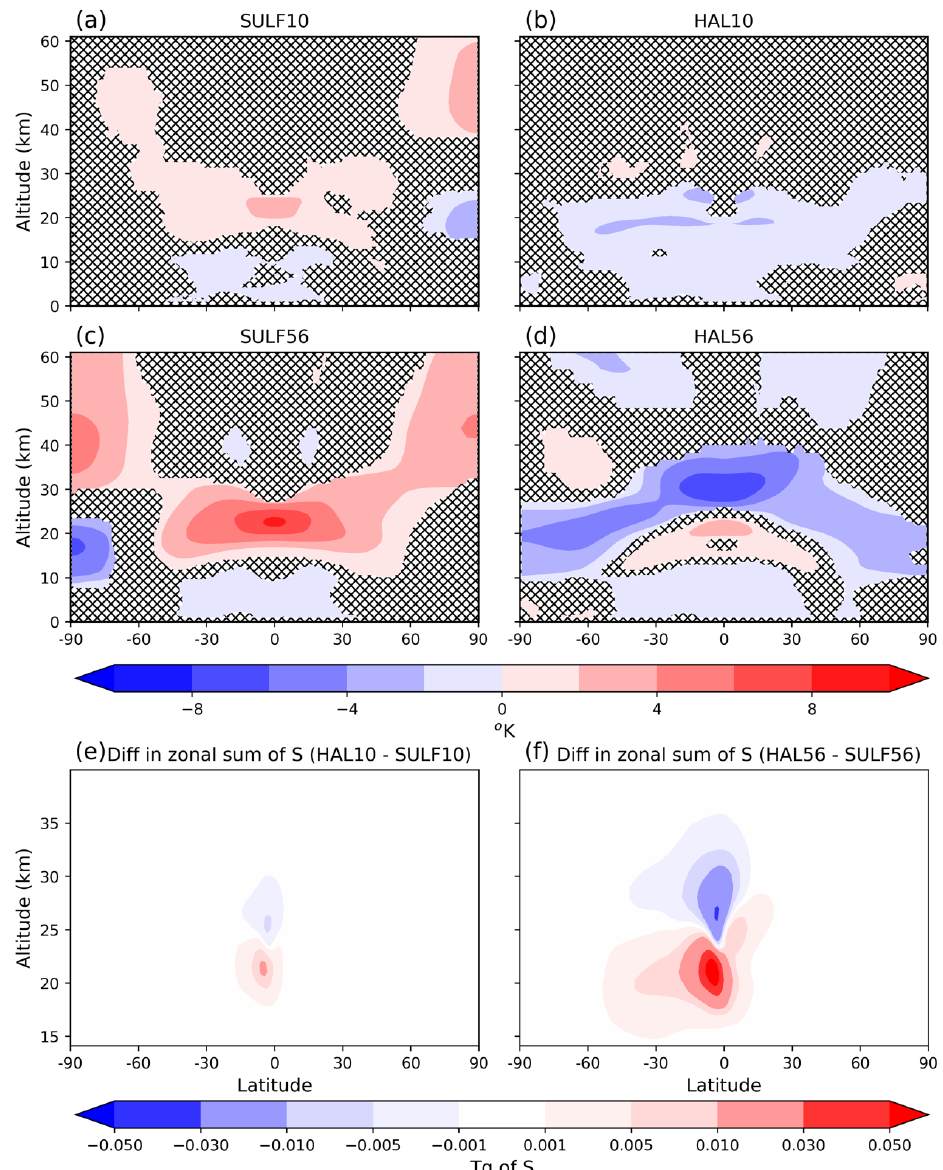
Figure 2. Zonal-mean temperature anomaly (K) averaged over the first post-eruption year relative to the control climatology: (a) SULF10, (b) HAL10, (c) SULF56, and (d) HAL56. Differences that are not significant at the 95% confidence interval according to a Mann–Whitney U test are indicated with stipples. Difference in zonal sum of total sulfur averaged over the first year post-eruption: (e) HAL10 − SULF10 and (f) HAL56 −